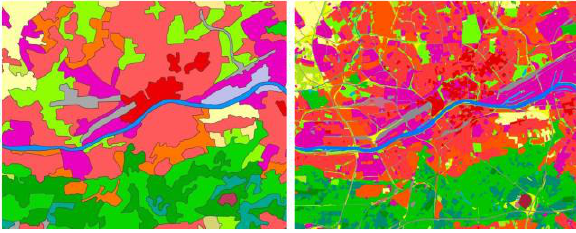
Figure 1. Land cover classes in Frankfurt am Main as seen in the CLC 2006 (left) with a coarser resolution and LBM-DE 2012 (right) The LBM-DE (LBM-DE for Land-Bedeckungs